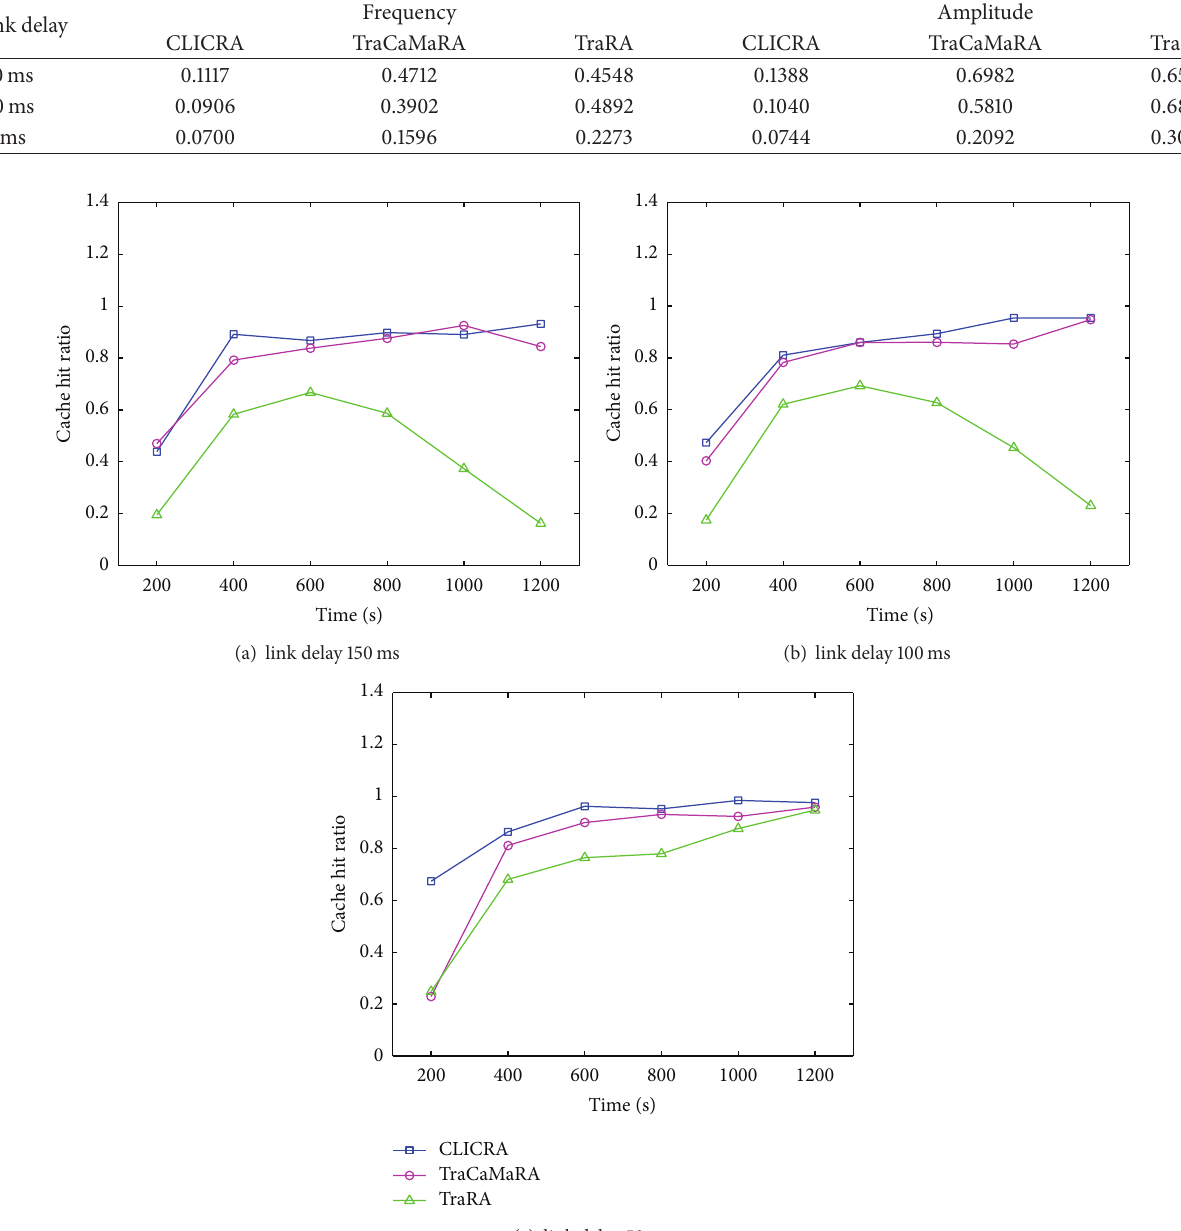
Figure 9: Average cache hit ratio of the clients over simulation time for receive window 60